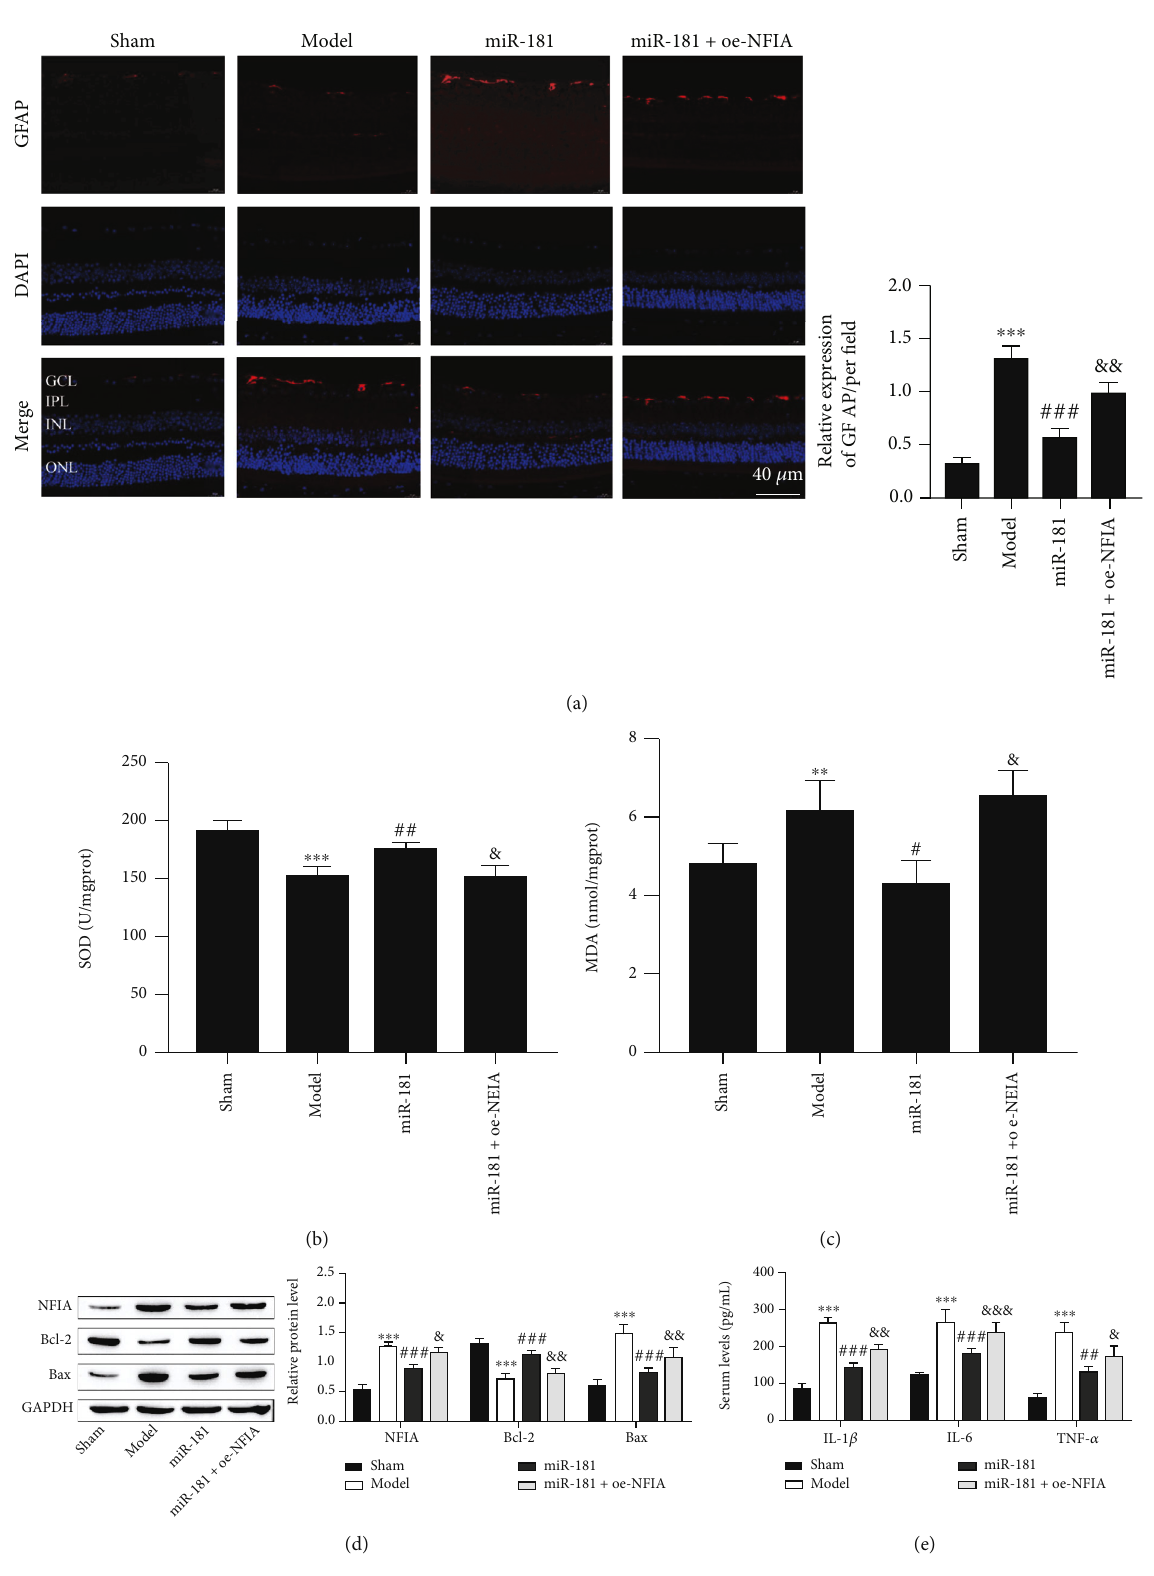
Figure 6: miR-181d-5p relieves astrocyte development, oxidative stress, and in fl ammation by targeting NFIA. (a) GFAP staining ( scale bar = 40 μ m). (b) SOD activity. (B) MDA content. (d) Western blot of Bcl-2 and Bax protein. (e) Proin fl ammatory factor levels were measured by ELISA. ∗∗ P < 0 : 01 and ∗∗∗ P < 0 : 001 vs. the sham group; # P < 0 : 05 , ## P < 0 : 01 , and ### P < 0 : 001 vs. the model group; & P < 0 : 05 , && P < 0 : 01 , and &&& P < 0 : 001 vs. the miR-181